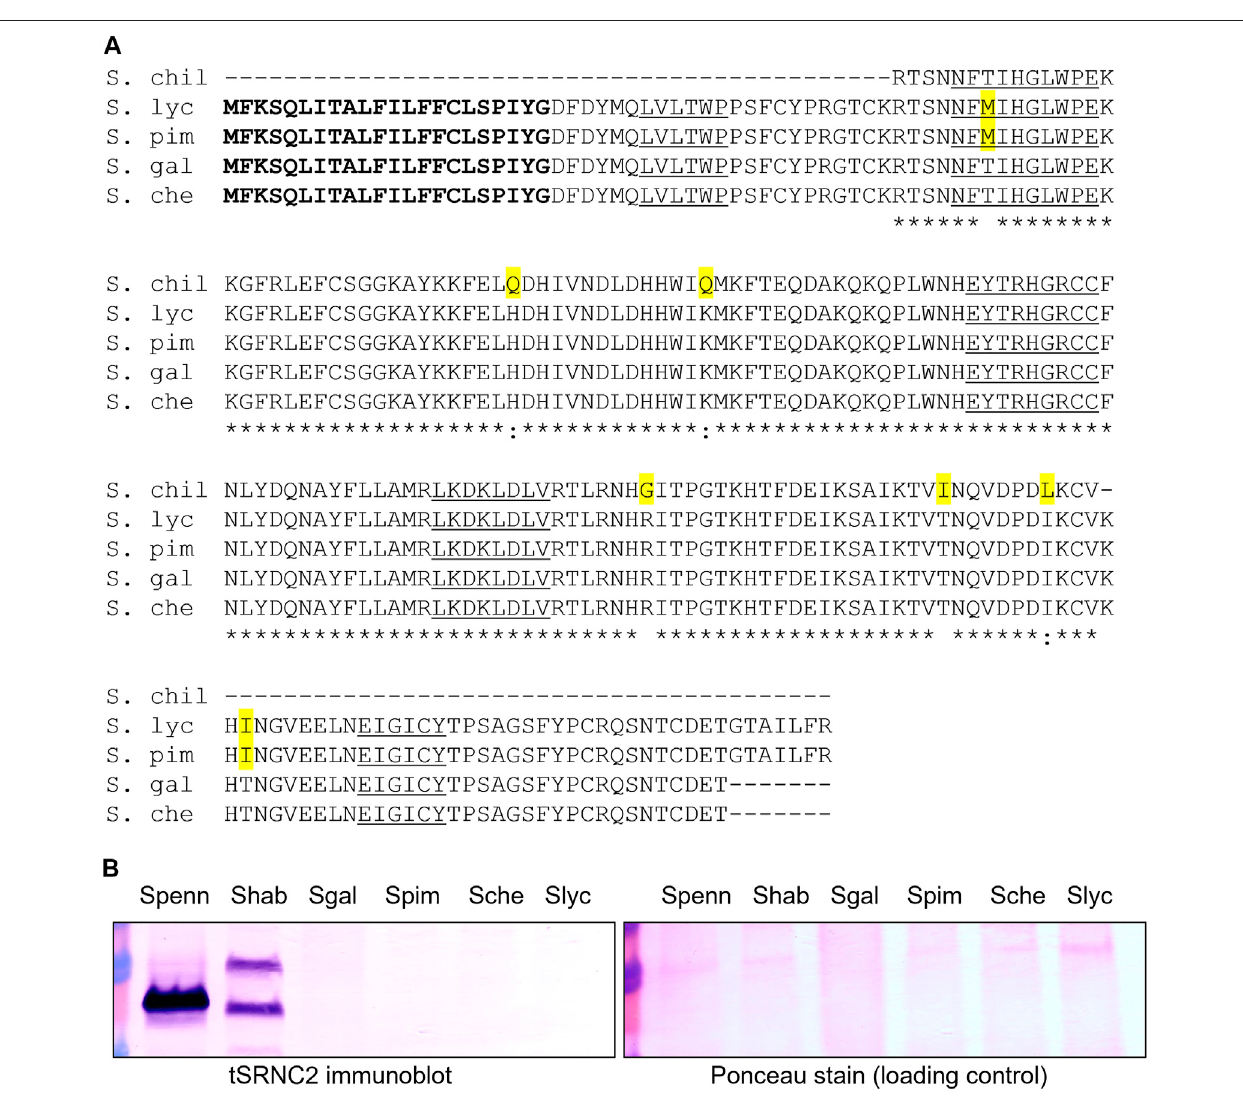
FIGURE1| S-RNasealignmentandimmunoblotfromfourred/orange-fruitedtomatospecies. (A) alignmentofdeducedaminoacidsequencesS.chil (cid:1) S.chilense S20 S-RNase, partial sequence (Igi ć et al., 2007) GenBank EF680098, S. lyc (cid:1) S. lycopersicum cultivar Heinz 1706 (Li and Chetelat, 2015) Sol Genomics Network (https://solgenomics.net) Solyc01g055200.1, S. pim (cid:1) S. pimpinellifolium accessionLA1589codingsequences SolGenomics Network Sopim01g055200.0.1, S.gal (cid:1) S.galapagense accessionLA0317PCRproduct,thisstudy,GenBankOK091157,S.che (cid:1) S.cheesmaniae accessionLA0522PCRproduct,thisstudy,GenBank OK091158. The predicted signal peptide is bolded, amino acid substitutions are highlighted in yellow and conserved S-RNase sequences C1-C5 are underlined. Asterisks indicate conservation between all sequences. (B) Immunoblot of stylar extracts using the tSRNC2 antibody raised to the conserved C2 region of S-RNases. Ponceau Stain of the membrane is shown as a loading control. Extracts from two SI plants were run as positive controls. Spenn (cid:1) SI S. pennellii LA1340, Shab (cid:1) SI S. habrochaites LA1777, Sgal (cid:1) SC S. galapagense LA0438, Spim (cid:1) SC S. pimpinellifolium LA1245, Sche (cid:1) SC S. cheesmaniae LA0522, Slyc (cid:1) SC S. lycopersicum